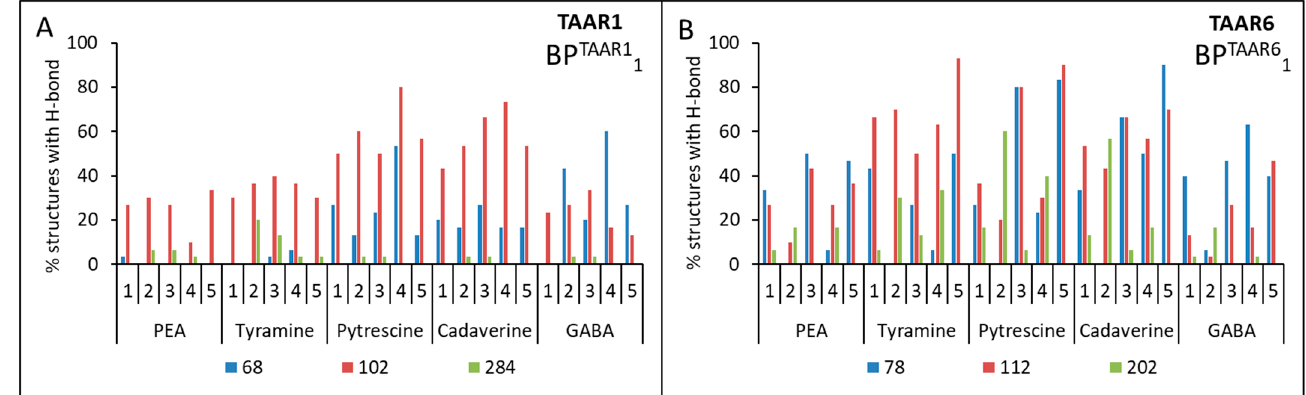
Figure 5. Percentage of structures in which the formation of hydrogen bonds between ligands and the corresponding aspartic amino acids of the receptors is observed. A series of computational experiments when triplets of aspartic amino acids BP TAAR11 ( A ) and BP TAAR61 ( B ) were included in the binding pocket.